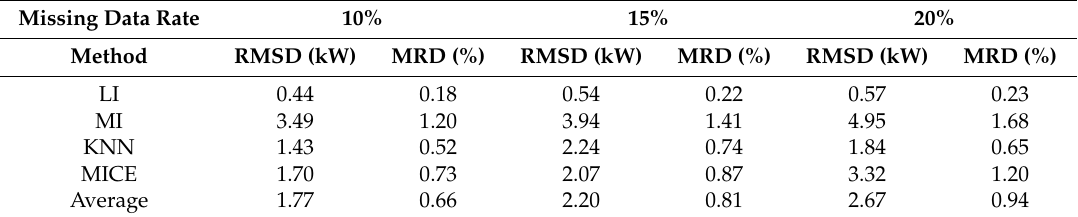
Table 3. Deviation of missing data imputation from the PV forecasting model in March using the test set.